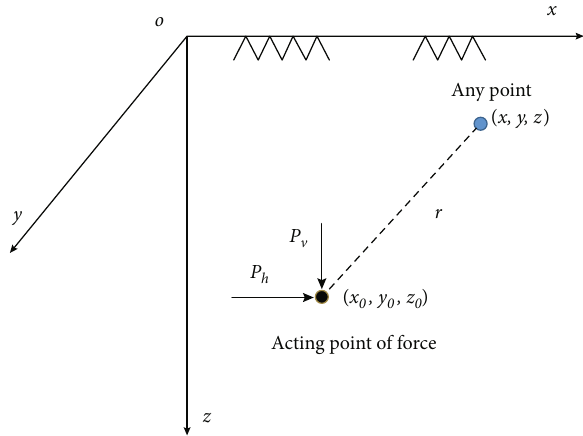
Figure 3: Mindlin solution calculation diagram.